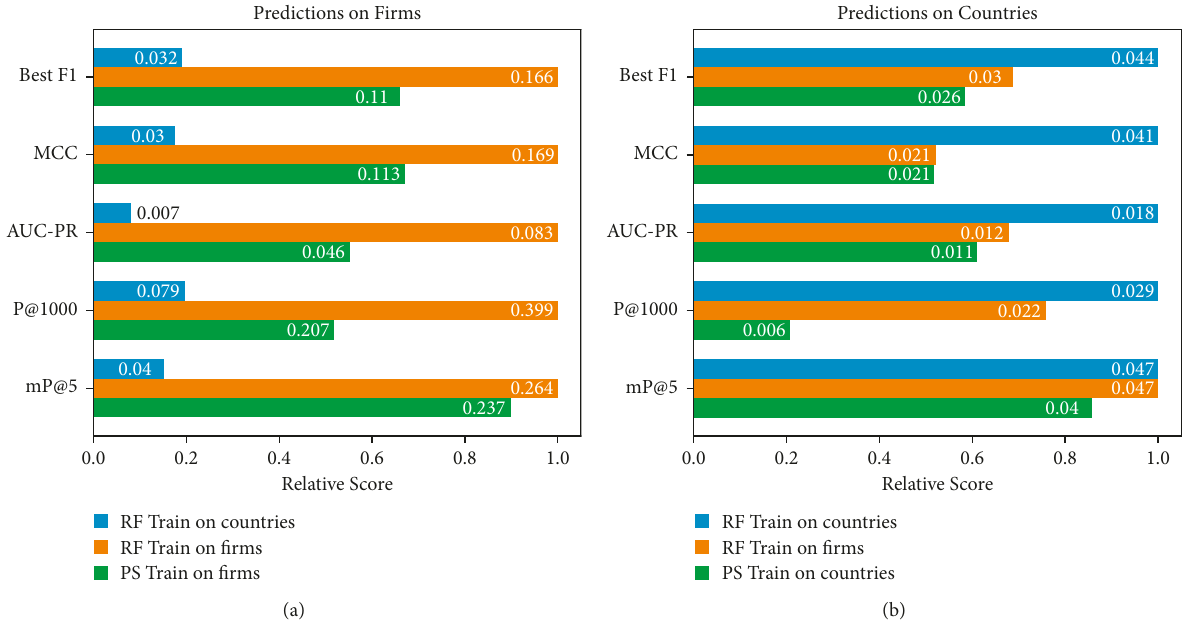
Figure 2: Comparison using different metrics between random forest built on firms and built on countries when we predict future exports of both firms (a) and countries (b). The orange bars refer to a random forest that has been trained on firm-level data, the blue bar refers to a random forest trained on country-level data, and the green bar refers to a product space built on firms (a) or country (b) data. The best assessment of relatedness at the country and at firm level is given by the relative random forest. However, the relatedness computed at the firm level performs better than the product space also at the country level.